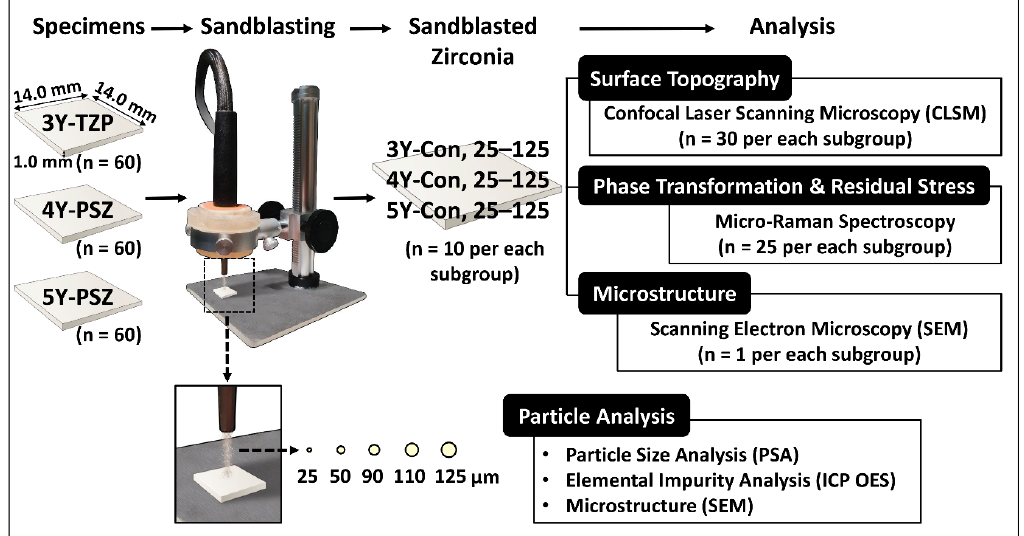
Figure 1. Flow chart of the experimental procedure; specimen preparation and Al 2 O 3 sandblasting conditions as well as the analytical methods associated with surface topography, residual stresses, microstructure, and Al 2 O 3 particle analysis are depicted. 3Y-TZP: 3 mol% yttria-stabilized tetragonal zirconia polycrystal; 4Y-PSZ: 4 mol% partially-stabilized zirconia; 5Y-PSZ: 5 mol% partially-stabilized zirconia; CLSM: confocal laser scanning microscopy; ICP OES: inductively coupled plasma optical emission spectrometry.